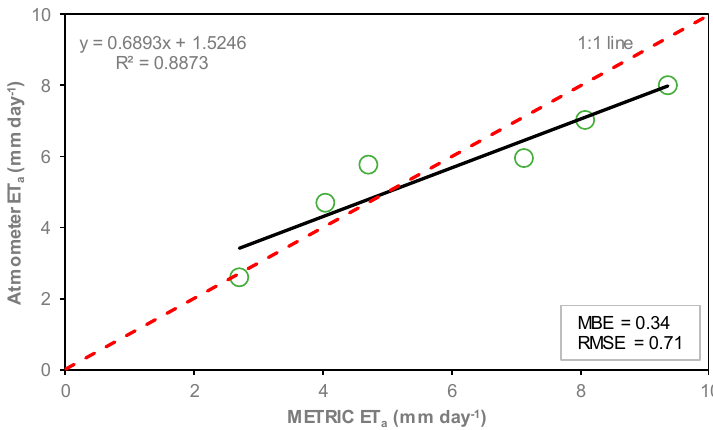
Figure 16. Relationship between ET a estimated by the METRIC model and estimated by atmometer during the period of study. The red dashed line represents 1:1 line.